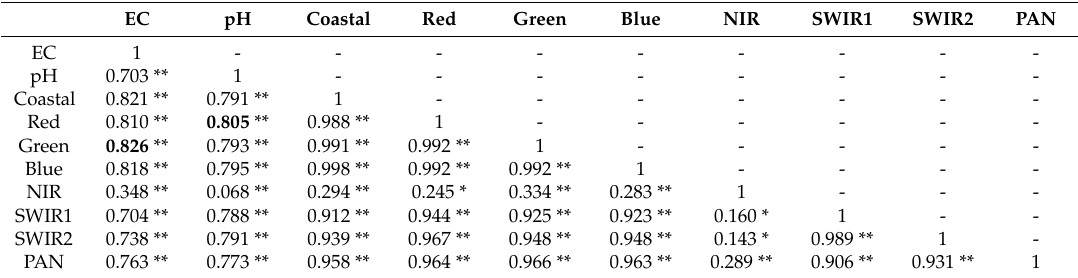
Table 2. Correlation coefficients between band reflectance, soil pH and